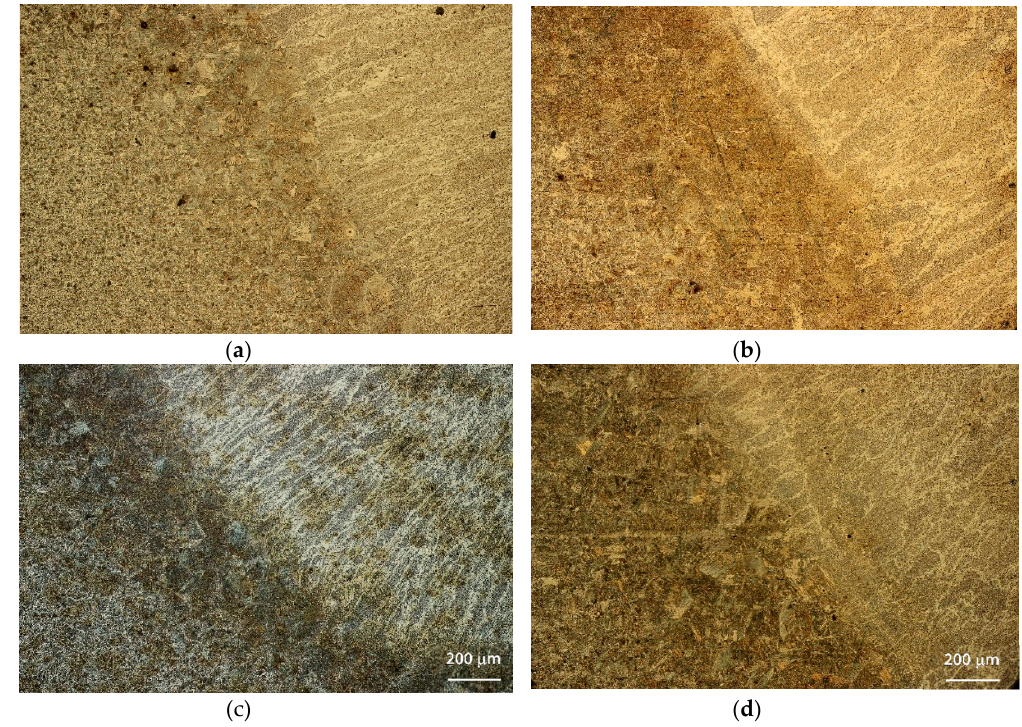
Figure 7. Comparative metallurgical cross-sections through the fusion zone and heat-a ff ected zone of A516 steel, at di ff erent vibration frequencies: ( a ) No vibration, ( b ) 12.8 Hz, ( c ) 58.4 Hz, ( d ) 60 Hz.